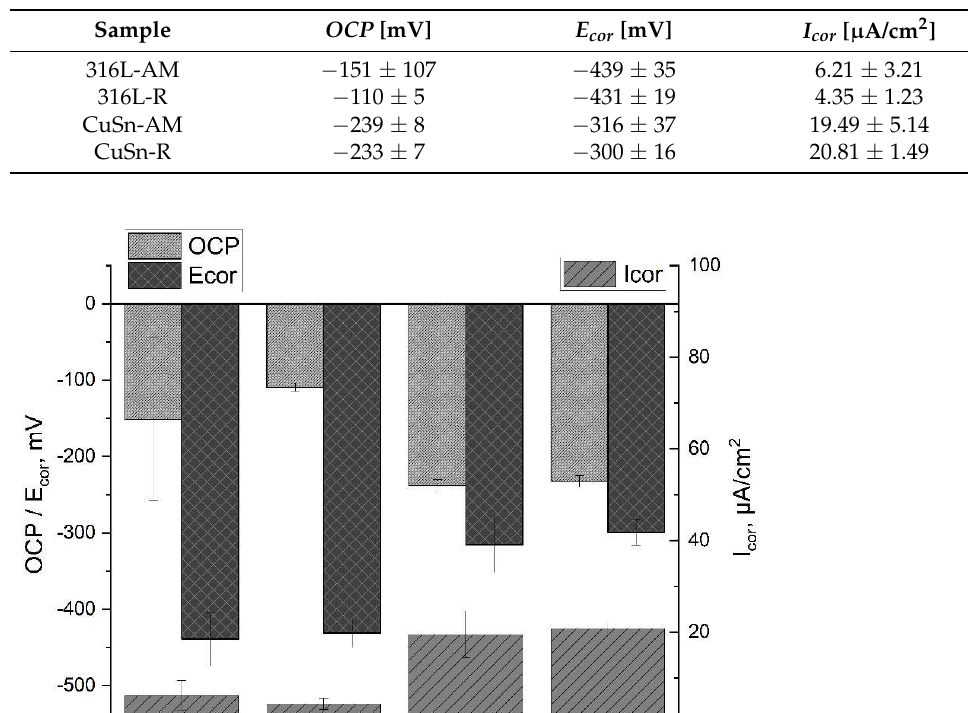
Table 7. LSV measured values of the additively manufactured samples with the rolled samples.